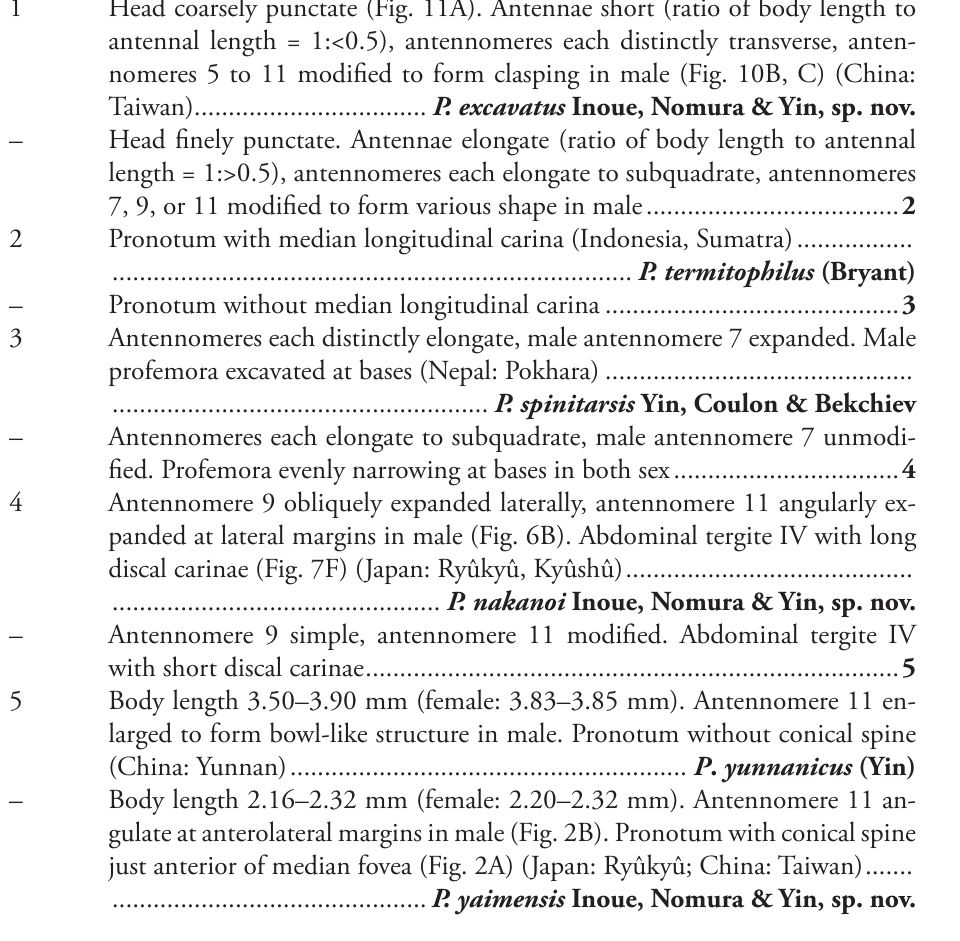
gulate at anterolateral margins in male (Fig. 2B). Pronotum with conical spine just anterior of median fovea (Fig. 2A) (Japan: Ryûkyû; China: Taiwan) .......